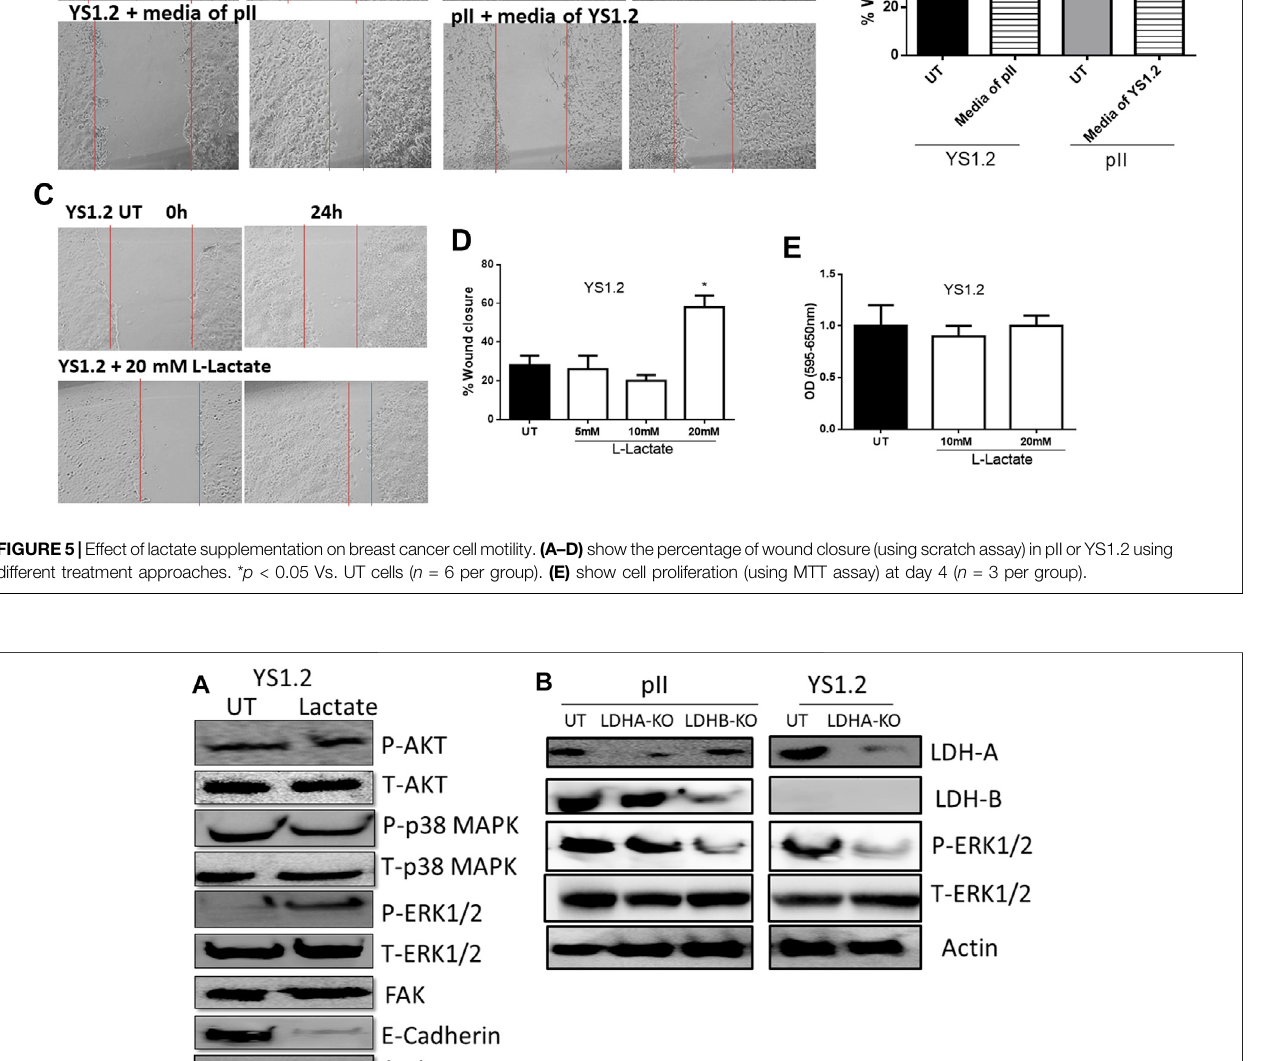
Frontiers in Pharmacology |